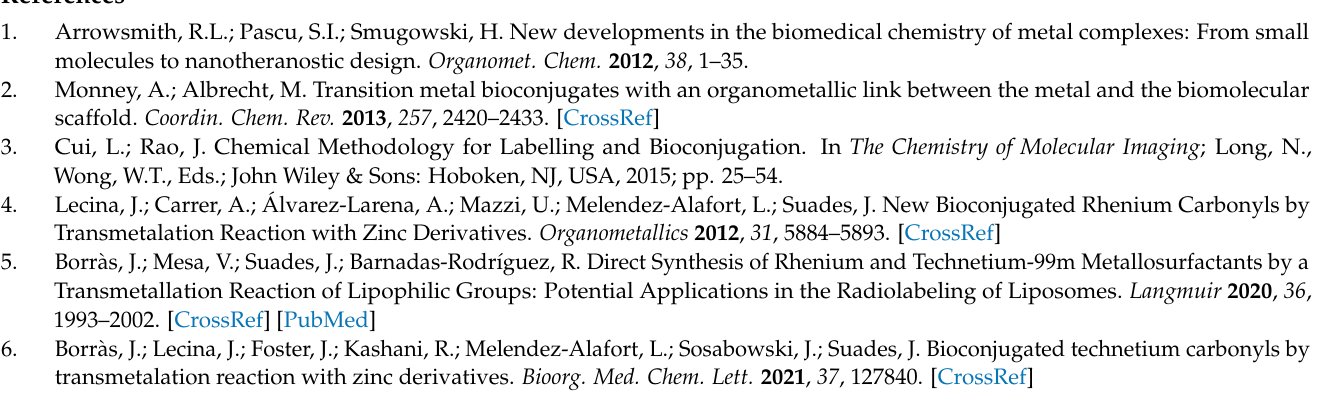
Spectroscopic data for 2 (Zn) (IR). Figure S3: Spectrometric data for 2 (Zn) (HRMS). Figure S4: Spec- troscopic data for 3 (Zn) ( 1 H and 13 C NMR). Figure S5: Spectroscopic data for 3 (Zn) (IR). Figure S6: Spectrometric data for 3 (Zn) (HRMS). Figure S7: Spectroscopic data for 2 (Re) ( 1 H and 13 C NMR). Figure S8: Spectroscopic data for 2 (Re) ( 31 P). Figure S9: Spectroscopic data for 2 (Re) (IR). Figure S10: Spectrometric data for 2 (Re) (HRMS). Figure S11: Spectroscopic data for 3 (Re) ( 1 H and 13 C NMR). Figure S12: Spectroscopic data for 3 (Re) ( 31 P). Figure S13: Spectroscopic data for 3 (Re) (IR). Figure S14: Spectrometric data for 3 (Re)